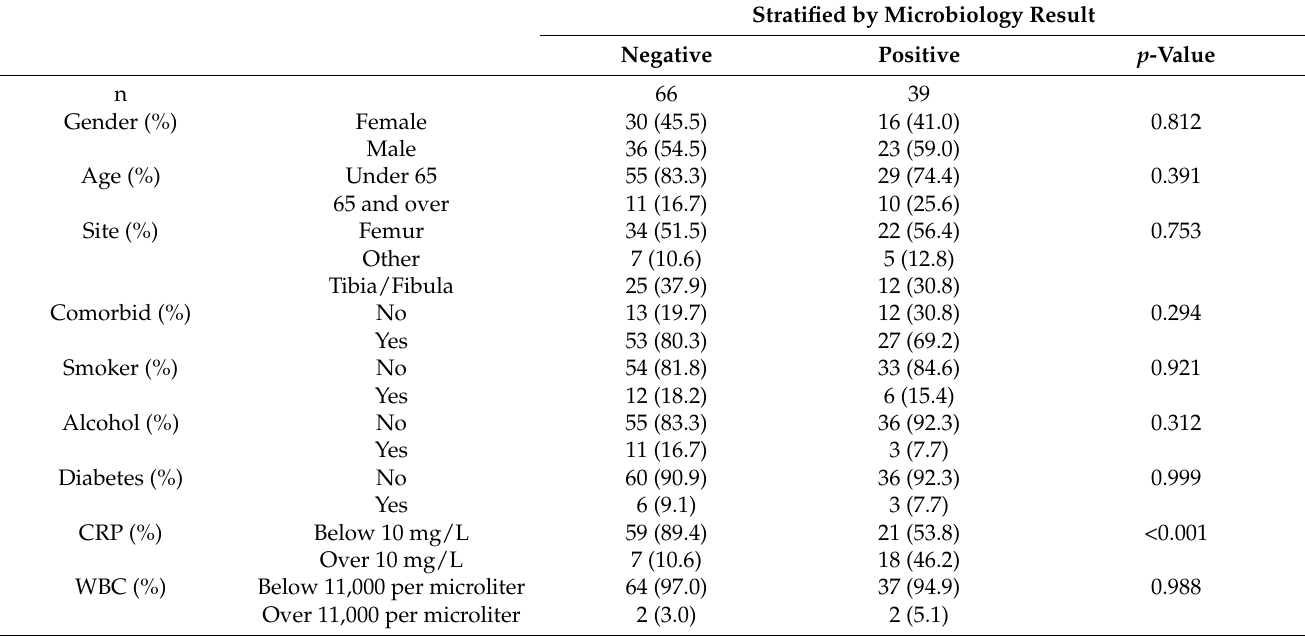
Table 1. Patient demographics, investigations and comorbidities.